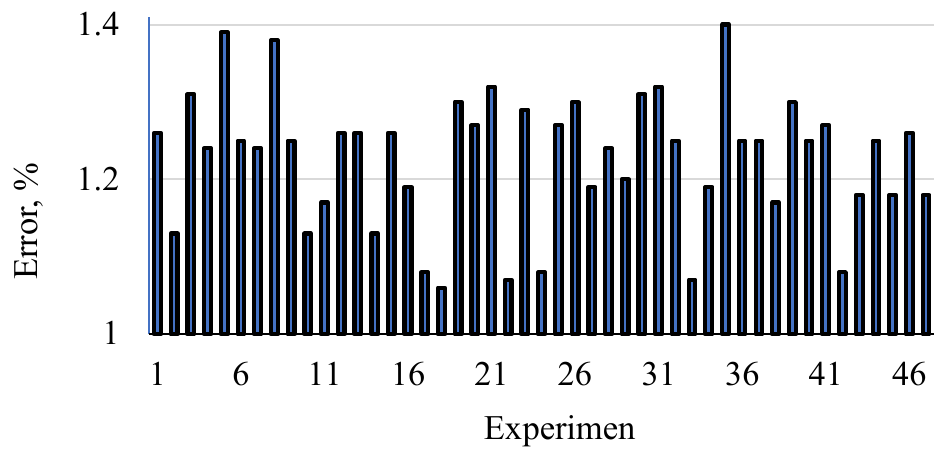
Figure 7. Error of bending strength estimation when applying the ANN modeling. The interactive effects of the independent variables on the MOR are given as a 3D plot in Figure 8a–c. It is evident from Figure 8a, where AC is at the middle level (15%), that the suitable level of MR is partly above 2:1 and the suitable level of WR is 10%. There is no positive effect on MOR, as the starch content increases even as the F to U molar ratio increases or decreases. Based on the ANOVA table, it is also observed, due to the non-significance of the direct effect x1 (MR) and the low F-value of the interactive effect x1x2, that the effect of MR is low, according to the slope variations in the 3D plot at all levels in the interaction with WR.